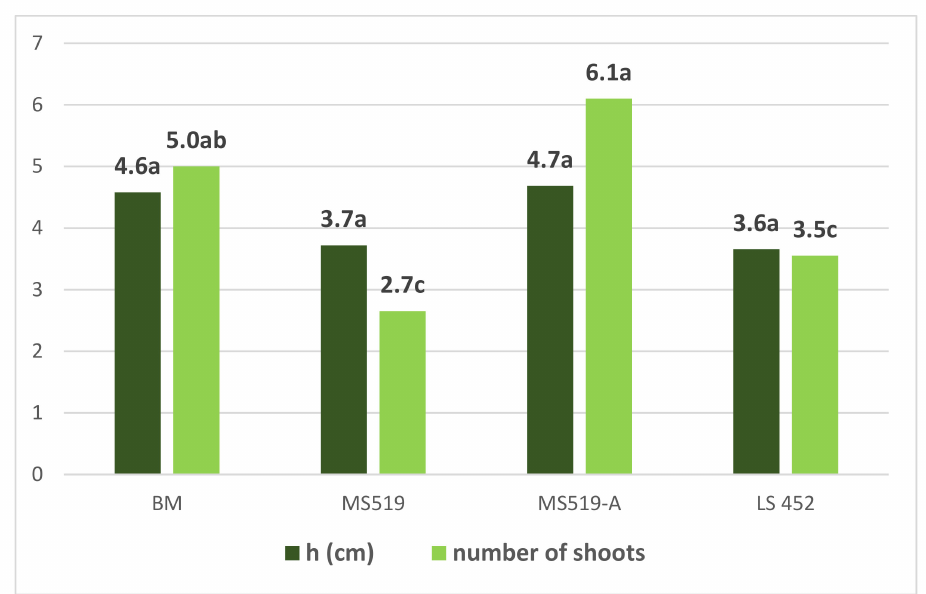
Figure 7. Effects of different media on shoots proliferation and elongation of ‘Troianella’ landrace. Data were recorded 3 weeks after each subculture on multiplication media and were a mean of three subcultures. Different letters for each column indicate significant differences between the different media tested (SNK test at p ≤ 0.001). No significant differences were observed in the shoot length.